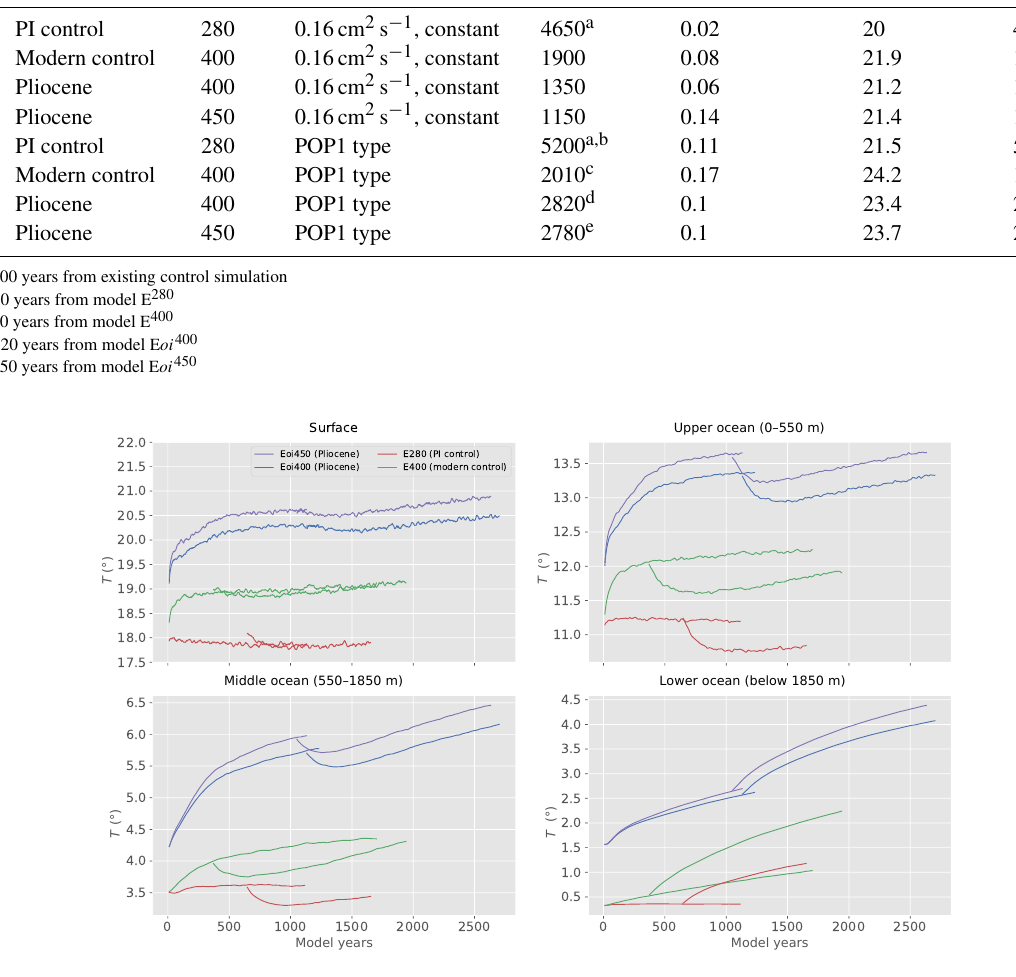
Figure 3. Evolution of the ocean temperature at different depths. When a new curve “forks” from an existing curve, it represents the branching of the P version of that simulation in which the ocean model κ has been fixed to the POP1 type profile. In all cases, the original simulation (with κ = 0 . 16 throughout the ocean) was also continued further in time. (a) The evolution of the sea surface temperature and the volume-averaged temperatures in the upper ocean at 0–550m of depth (b) , the middle ocean at 550–1850m of depth (c) , and the lower ocean below 1850m (d)